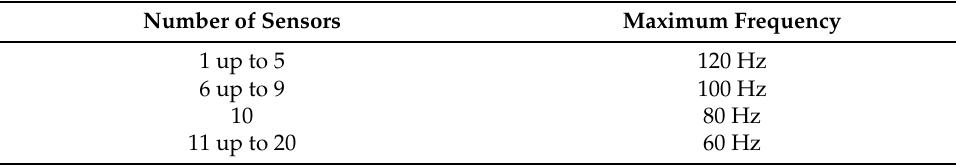
Table 1. Maximum frequency as a function of the number of sensors for the MTw. Number of